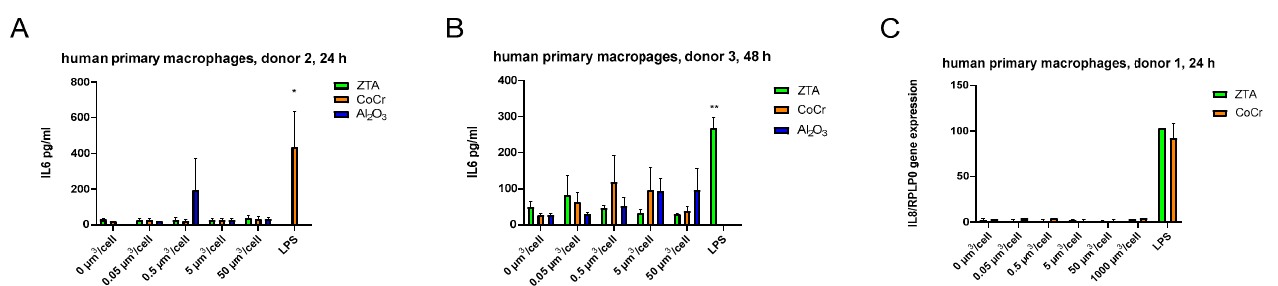
Figure 5. ZTA and CoCr particles do not induce IL-6 secretion or IL-8 gene expression in human primary macrophages. Human primary macrophages were treated with CoCr, ZTA, or Al 2 O 3 particles, and the level of IL-6 was measured in the supernatant 24 h ( A ) and 48 h ( B ) after addition of particles by ELISA. The IL-8 gene expression level was measured by q-PCR 24 h after treatment ( C ). The results are expressed as the mean ± SEM. *— p < 0.05; ** p ≤